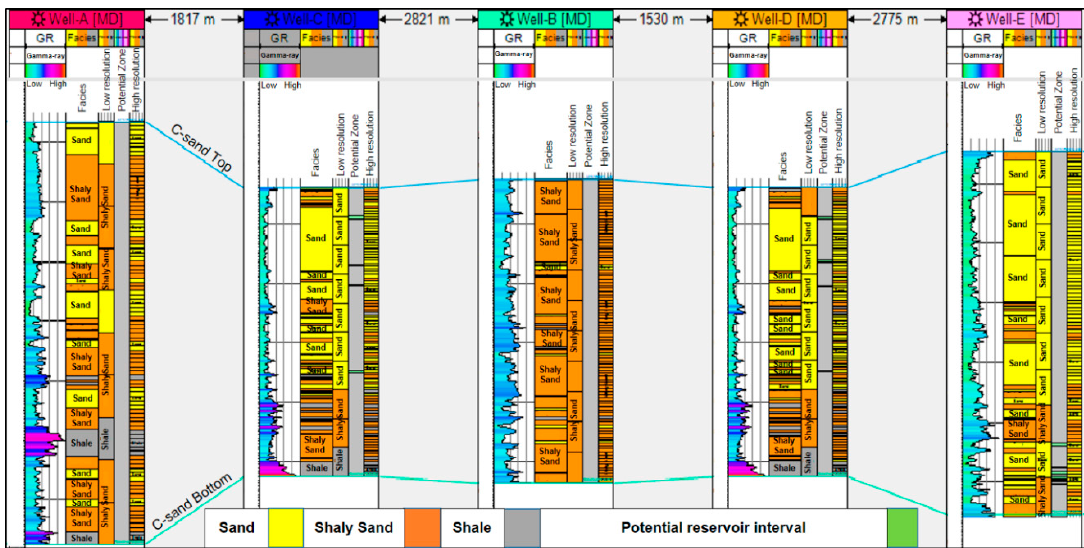
Figure 8. Comparison of facies analysis; Track B: Gamma-ray log, Track C: Facies analysis from well logs, Track D: Facies analysis from low-resolution up-scaling, Track F: Facies analysis from high-resolution up-scaling, and Track E: Potential reservoir zones.